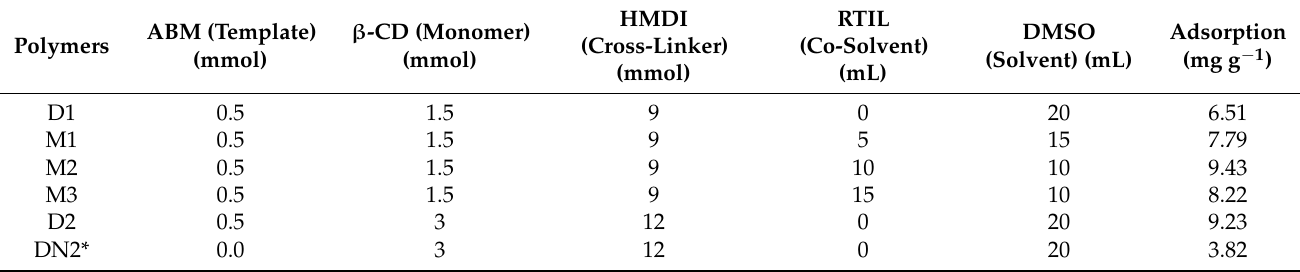
Table 1. Preparation protocol for ABM MIPs